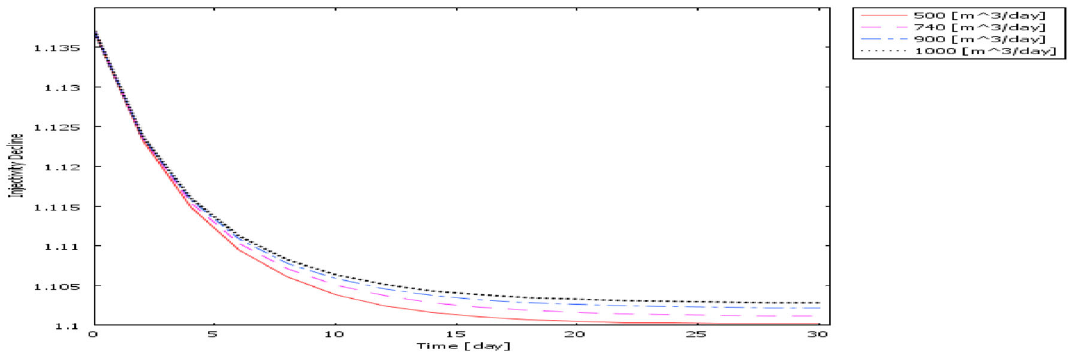
Fig. 16 Injectivity decline with time for different injection